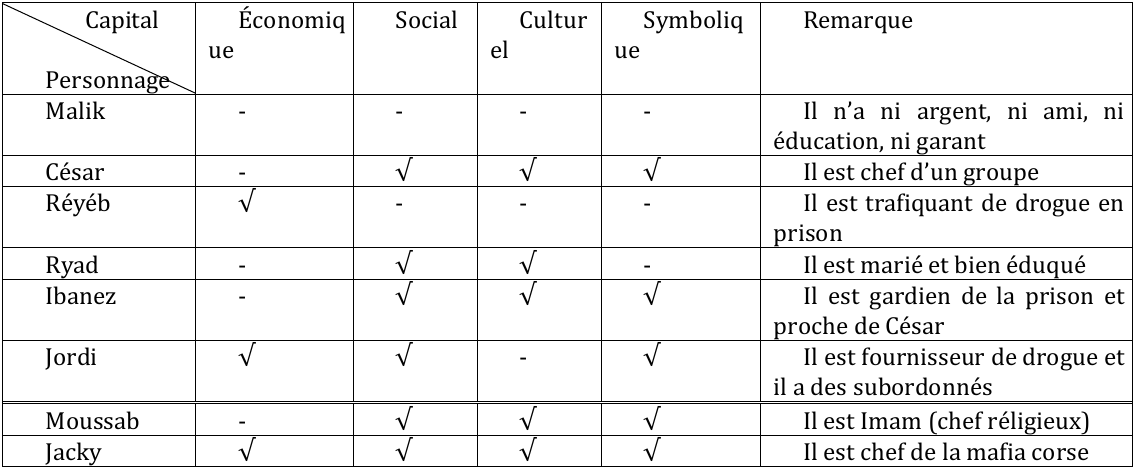
Tableu 1 La propriété initiale des capitaux des